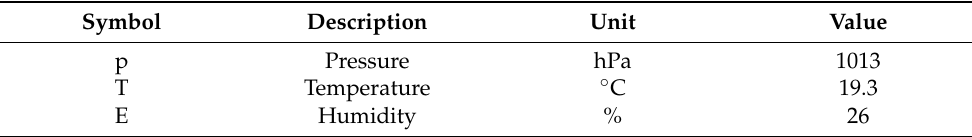
Table 2. Air parameters prevailing in the laboratory during the study.